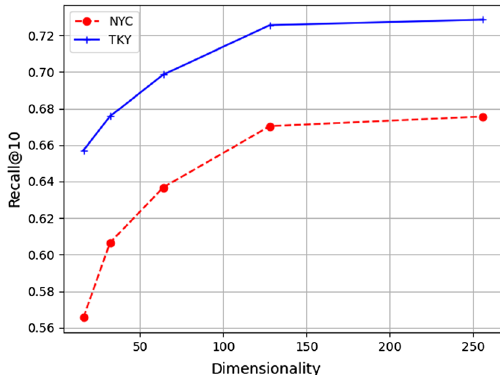
Fig. 5 Recall@10 value with varying hidden dimensionality of model on two datasets